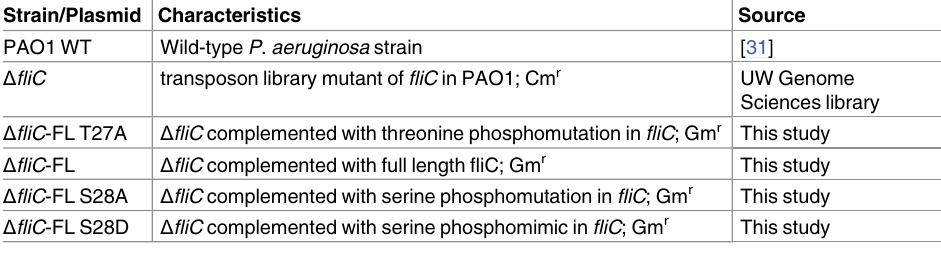
Table 1. Bacterial strains and plasmids used in this study.